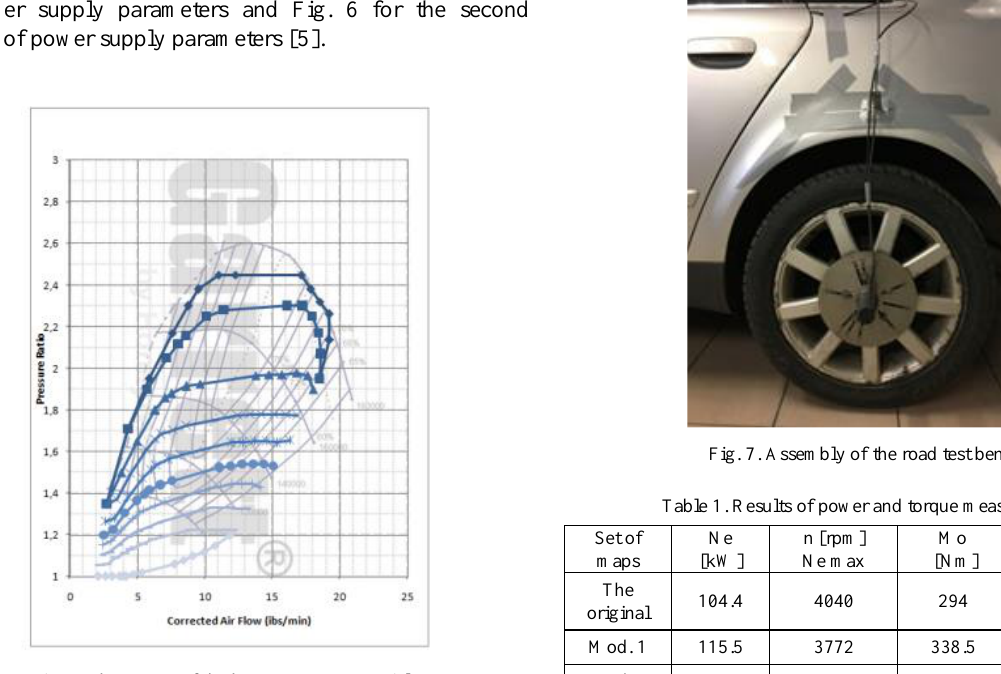
Fig. 5. The course of the boost pressure – serial 1